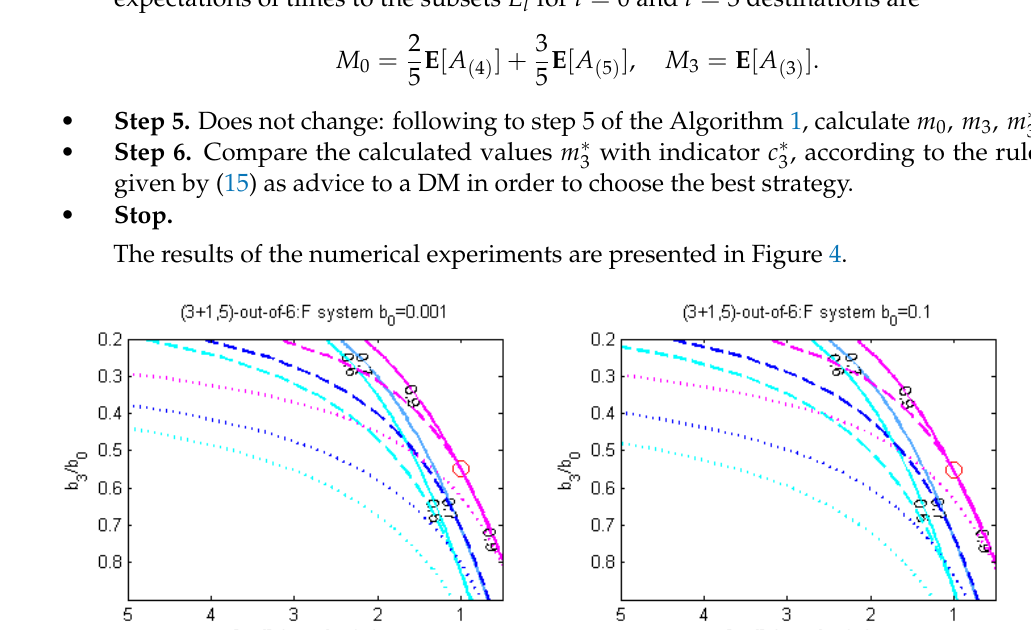
for ( 3 + 1,5 ) -out-of-6: F – b 0